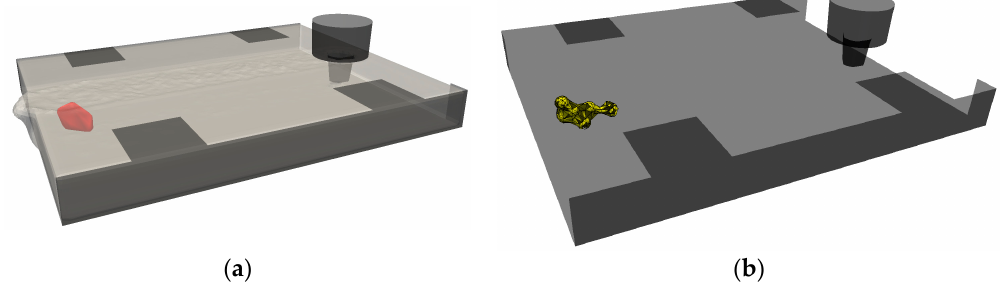
Figure 13. Comparison of predicted and measured defects at the end of the advancing phase for ω ∗ = 1194 rpm and V a ∗ = 790 mm/min: ( a ) simulation ( b ) experiment. Table 10. Comparison of predicted and experiment defect volume at optimal process parameters. Weld